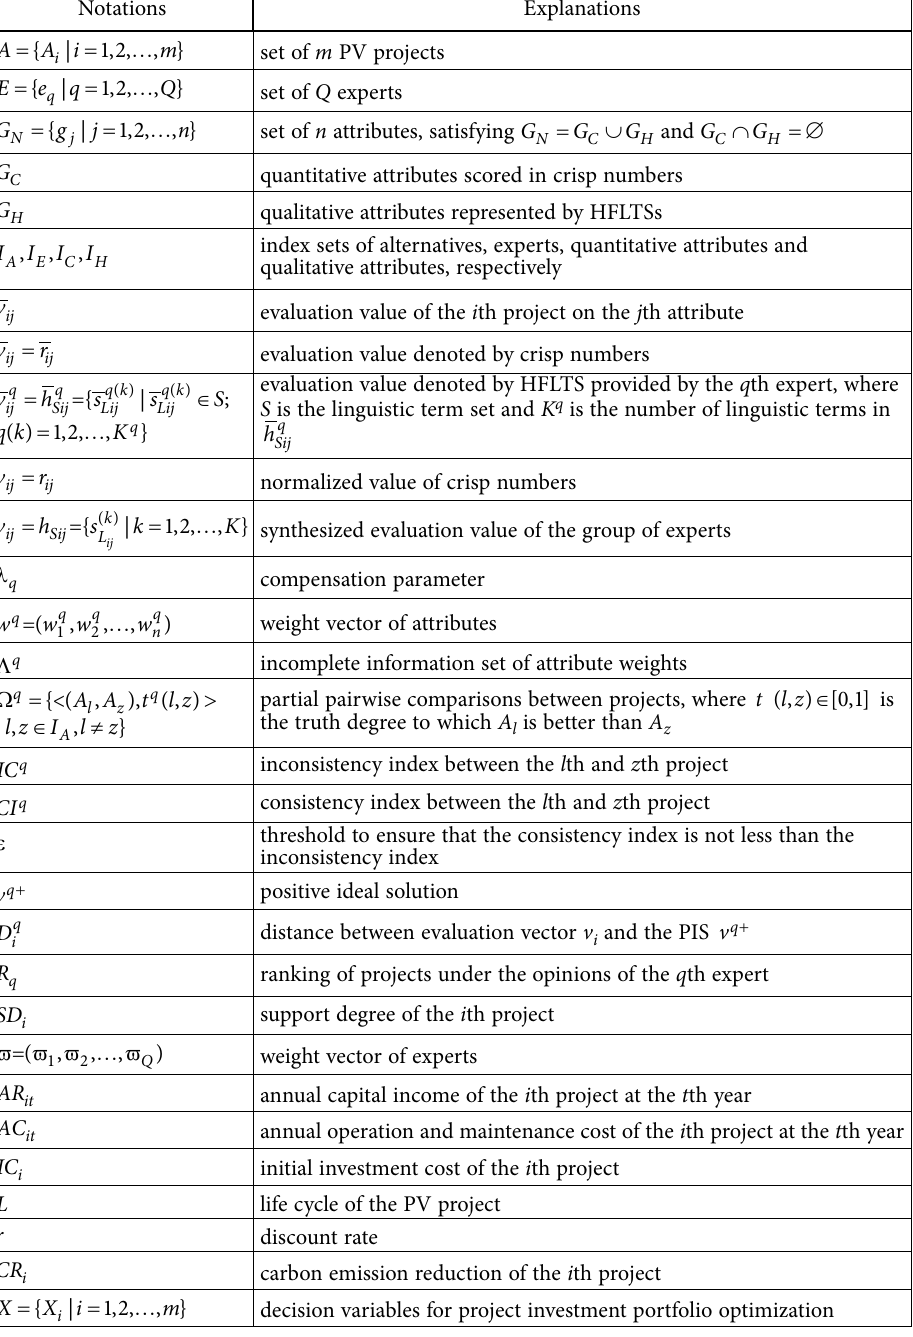
Table A.2. Notations and explanations